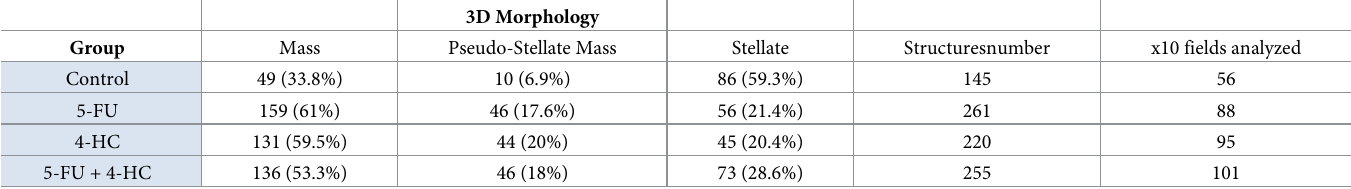
Table 1. Quantitative analysis of the morphological phenotypes displayed by 231/LM2-4 multicellular structures grown in a 3D lrECM “on-top” assay using Matri- gel as barrier. 3D